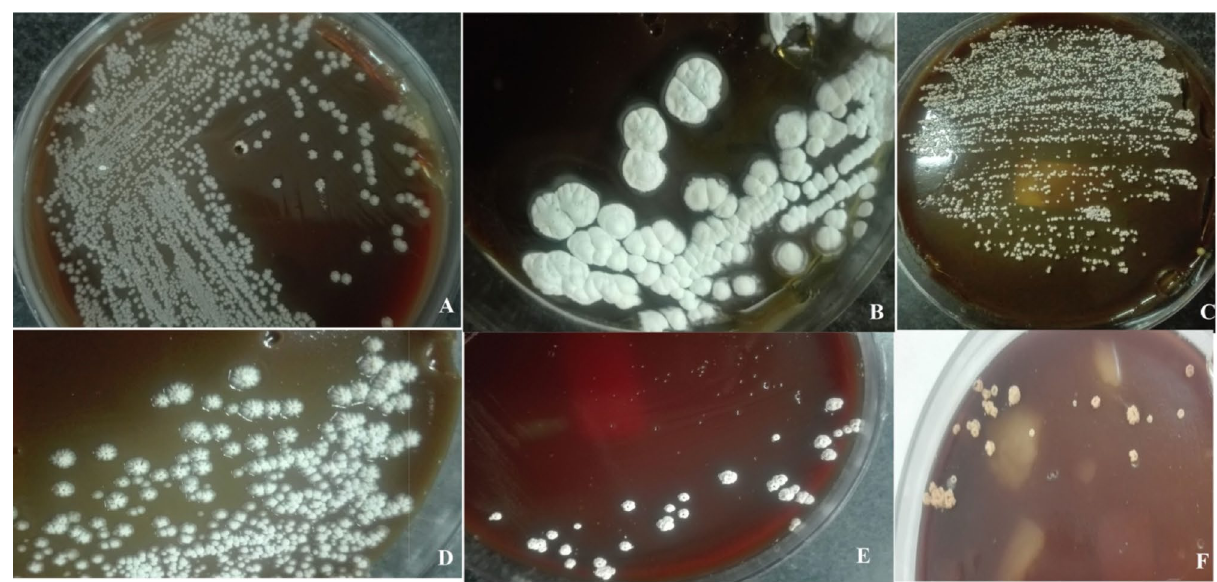
Figure 3. Pure colonies of isolated species ( A ) Nocrdia otitidiscaviarum , ( B ) Nocardiopsis dassonvillei ( C ) Nocardia cyriacigeorgica , ( D ) Nocardia ninae, ( E ) Nocardia.brasiliensis , ( F ) Rhodococcus